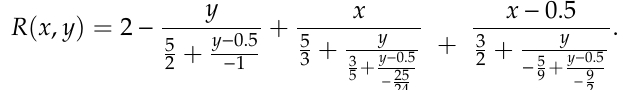
Figure 1. ( a ) Graph of R 2 ( x ) with λ = − 3, ( b ) graph of R 2 ( x ) with λ = 80.